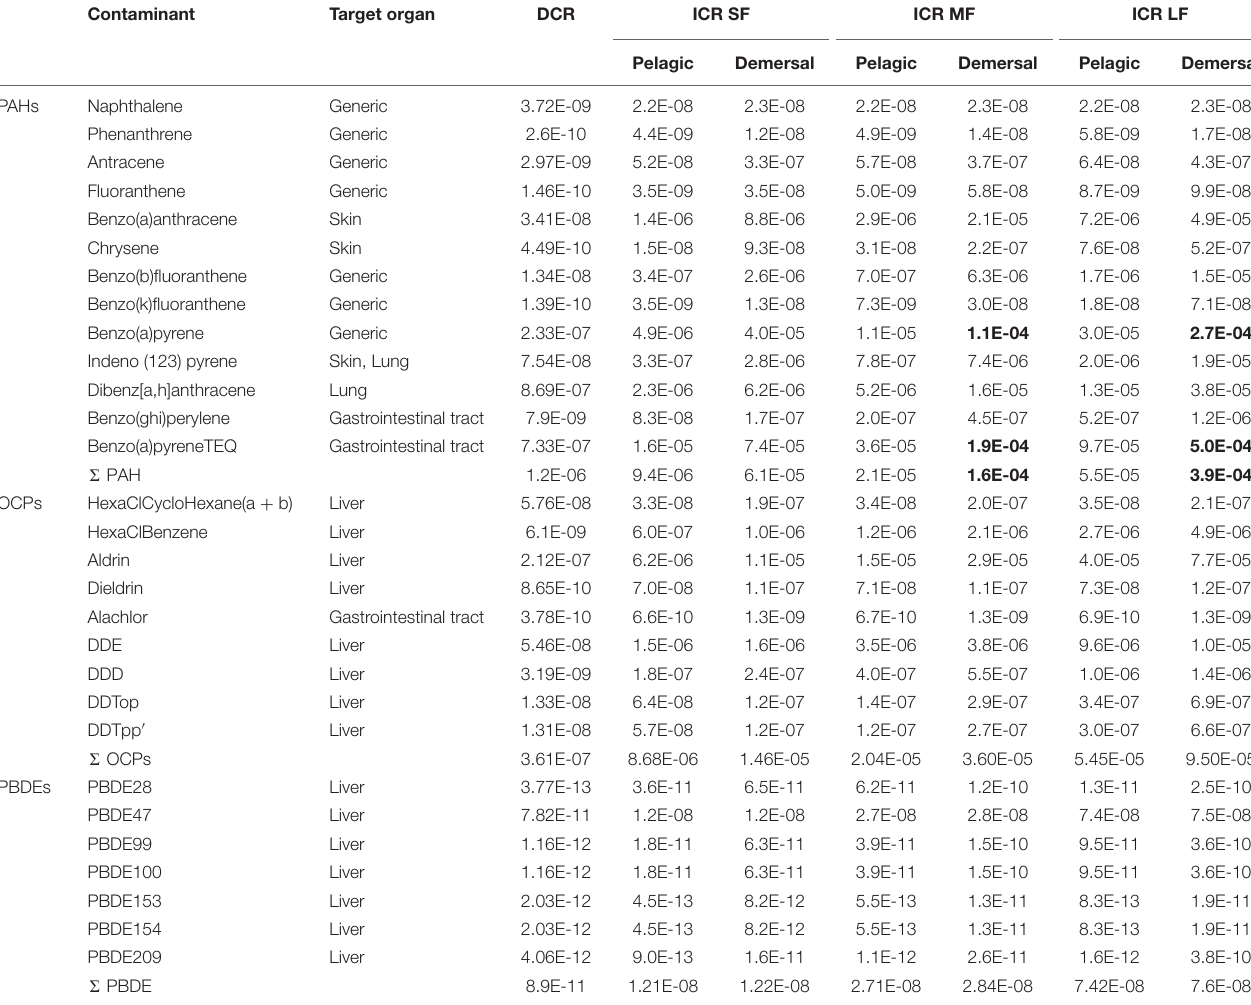
TABLE 4 | Mean Ingestion Cancer Risk (ICR) for small (SF), medium (MF), large (LF) pelagic, and demersal fish and mean Dermal Cancer Risk (DCR). Contaminant